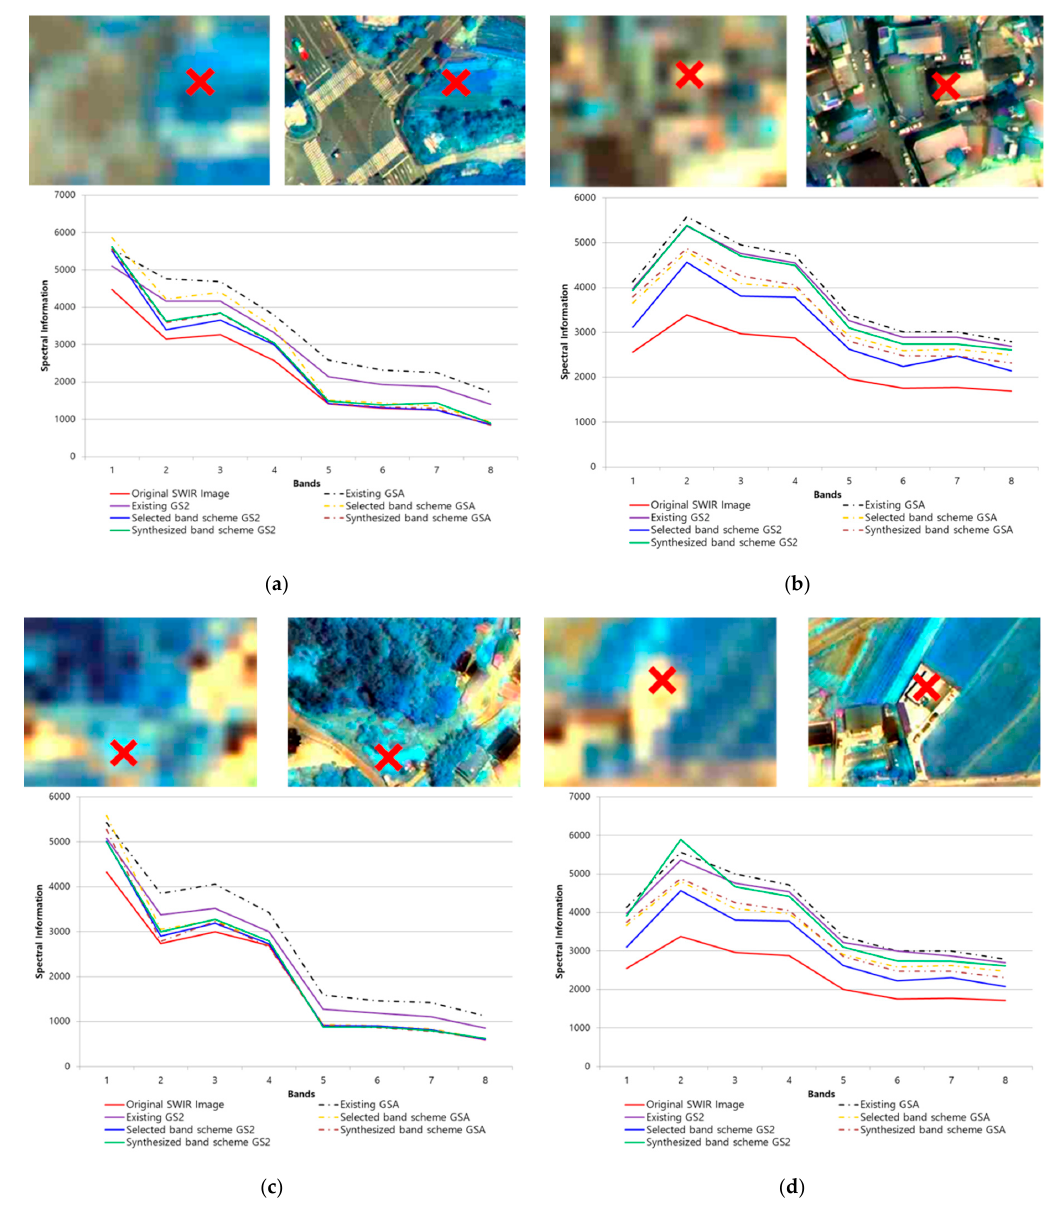
Figure 7. Comparison of spectral information between the original image and sharpened image (SWIR bands 8, 4, and 1 are shown as RGB): ( a ) comparison of spectral information of vegetation pixels in site 1; ( b ) comparison of spectral information of building roof pixels in site 1; ( c ) comparison of spectral information of vegetation pixels in site 2; ( d ) comparison of spectral information of building roof pixels in site 2.